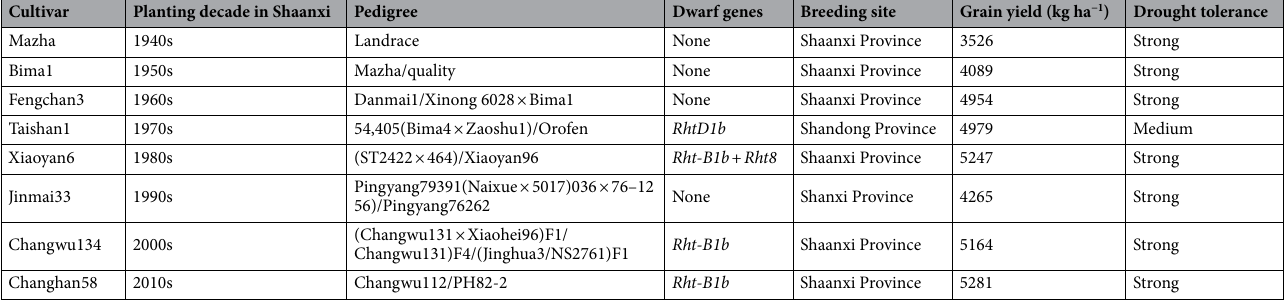
Table 1. Recorded traits of selected dryland winter wheat in Shaanxi Province during the 1940s–2010s.